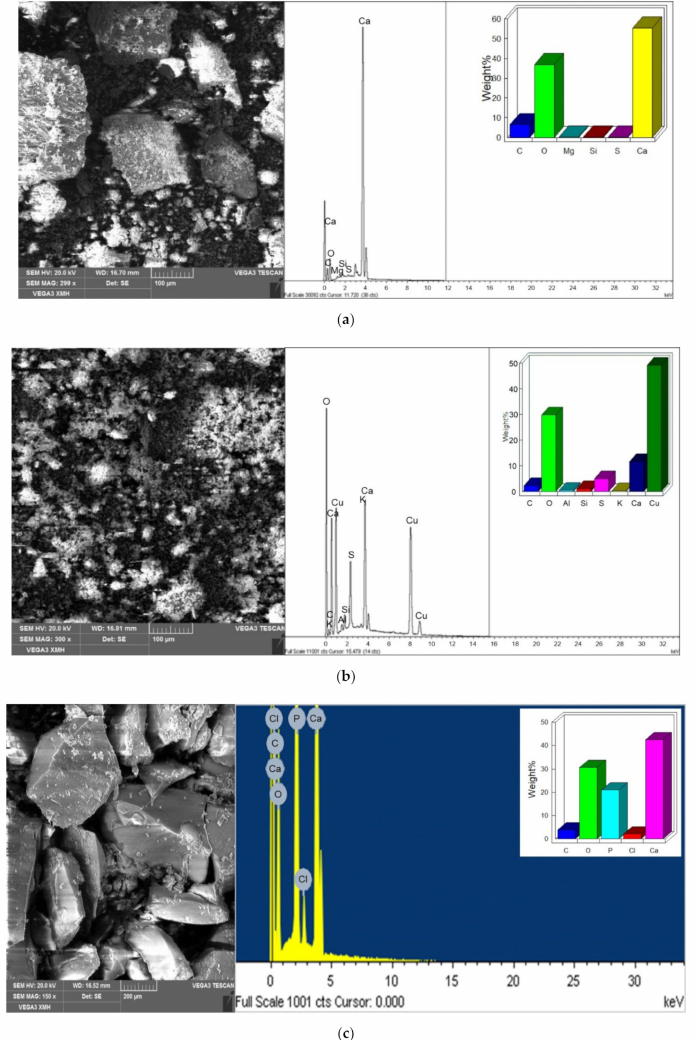
Figure 6. SEM surface micrograph, SE spectra, and contents of identified elements for the CFA–HAp2 composite: ( a ) before adsorption, ( b ) after Cu(II) adsorption, and ( c ) after RB